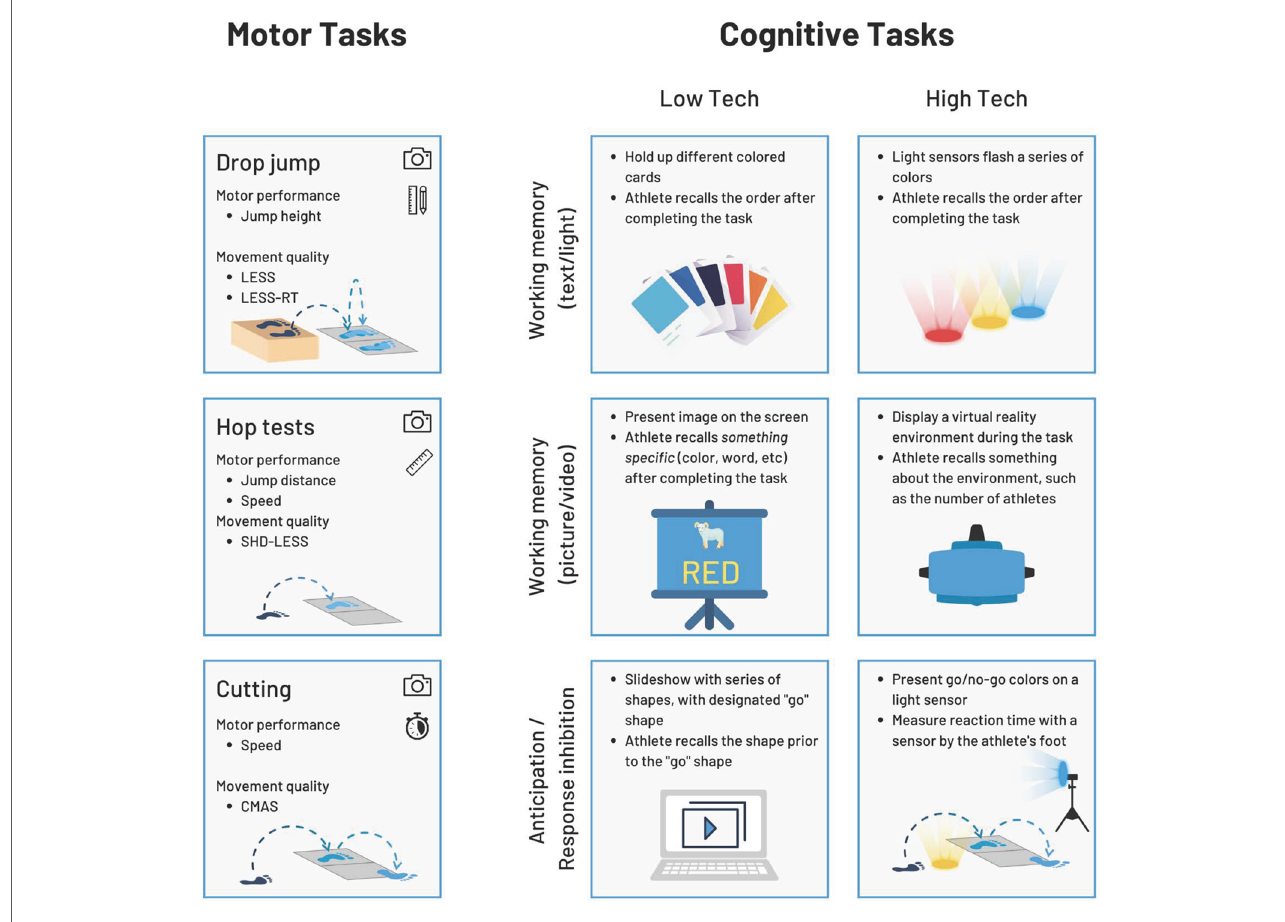
FIGURE 4 Cards with suggestions on implementation of motor tasks and cognitive tasks. LESS, landing error scoring system. LESS-RT, landing error scoring system real time. SHD-LESS, single hop for distance landing error scoring system. CMAS, cutting movement assessment score.